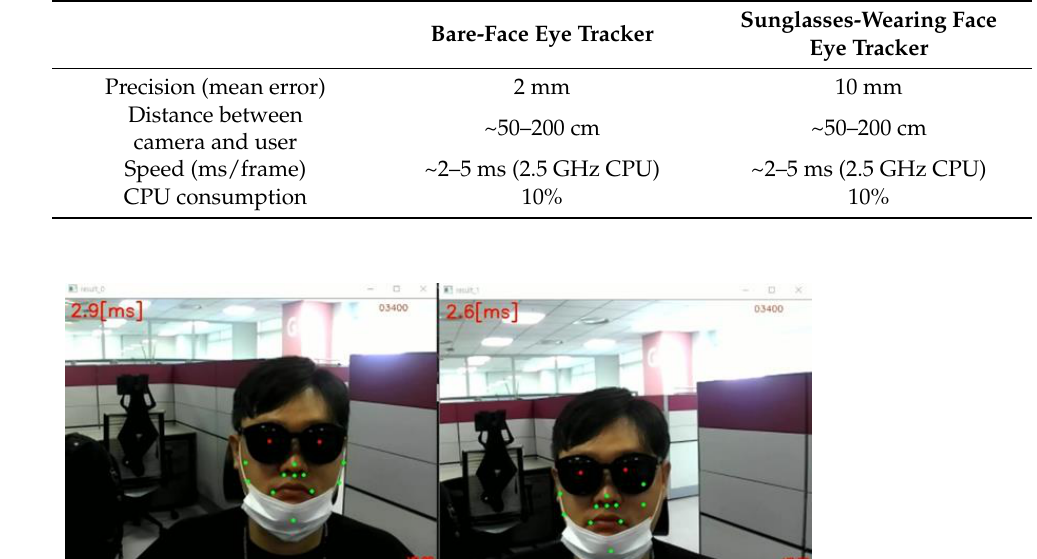
Table 1. Performance of the proposed eye-tracking method for bare and sunglasses-wearing faces.